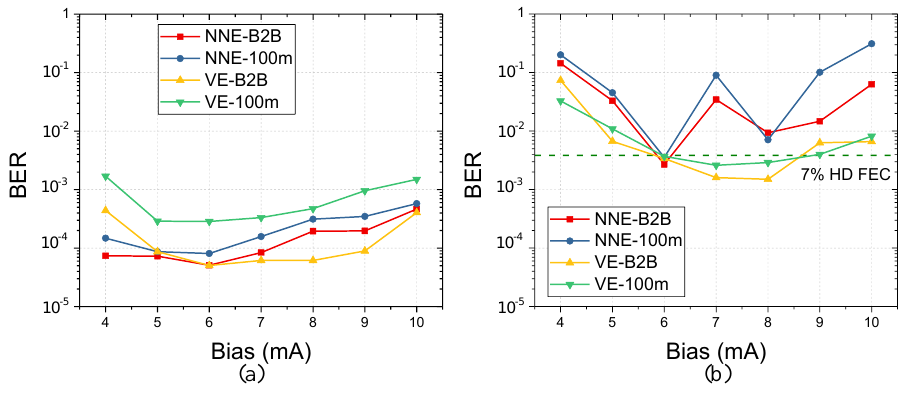
Figure 7. BER versus VCSEL DC bias for ( a ) VE and NNE ( b ) Pruned VE and